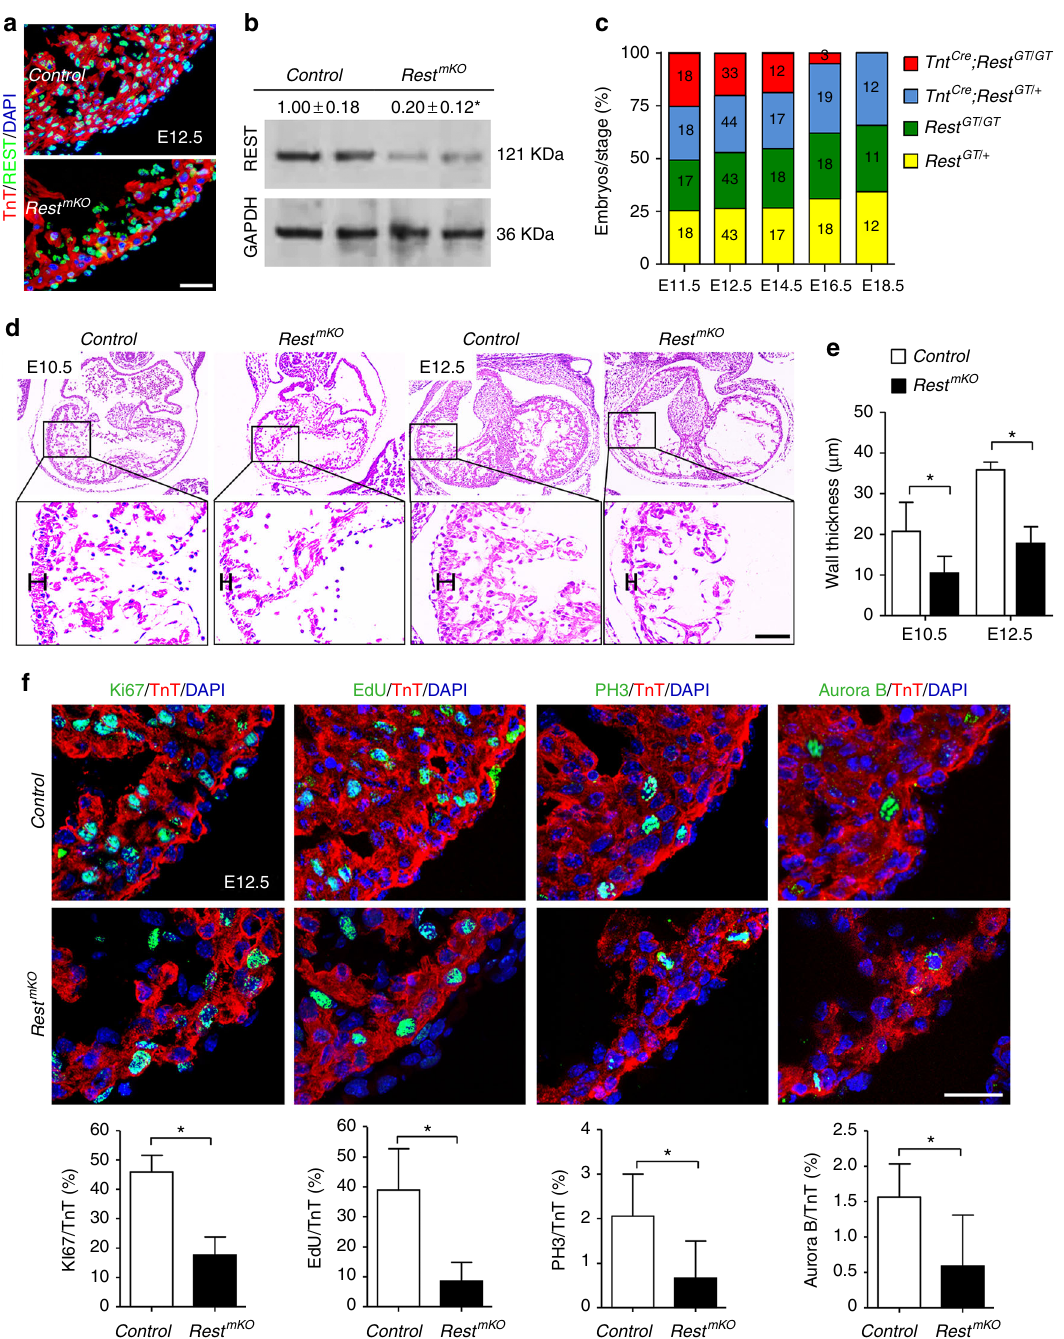
Fig. 1 Rest is required for myocardial development and cardiomyocyte proliferation. a , b Immunostaining and western blot analyses showing the ef fi cient deletion of Rest in cardiomyocytes in TnT Cre ; Rest GT/GT ( Rest mKO ) hearts. Controls were Rest GT/GT mice. c A summarizing graph of the distribution and number of embryos at different stages indicates death of Rest mko embryos between E12.5 and E16.5. d , e H&E-stained sections of E10.5 and E12.5 hearts indicate thin ventricular wall resulting from Rest deletion. f Quantitative immunostaining of cell cycle markers showing reduced proliferation of Rest mKO cardiomyocytes. n = 4/group, mean ± s.d., * p < 0.05 by unpaired two-tailed Student ’ s t test. Scale bars = 40 µ